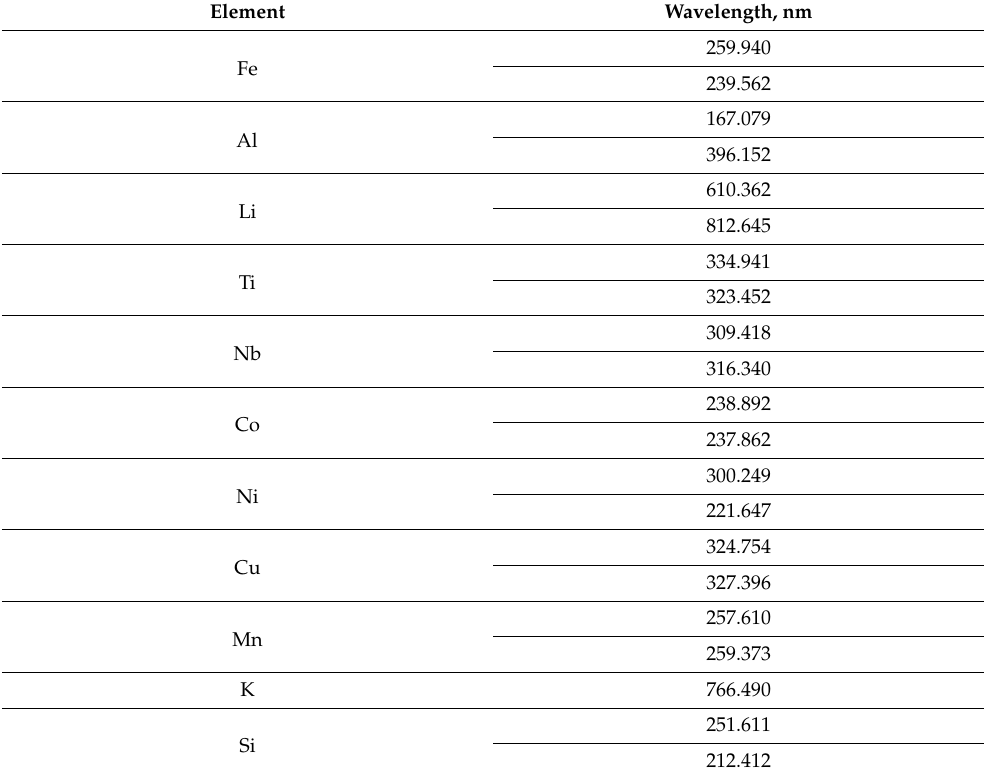
Table 2. Analytical lines of the elements being analyzed.